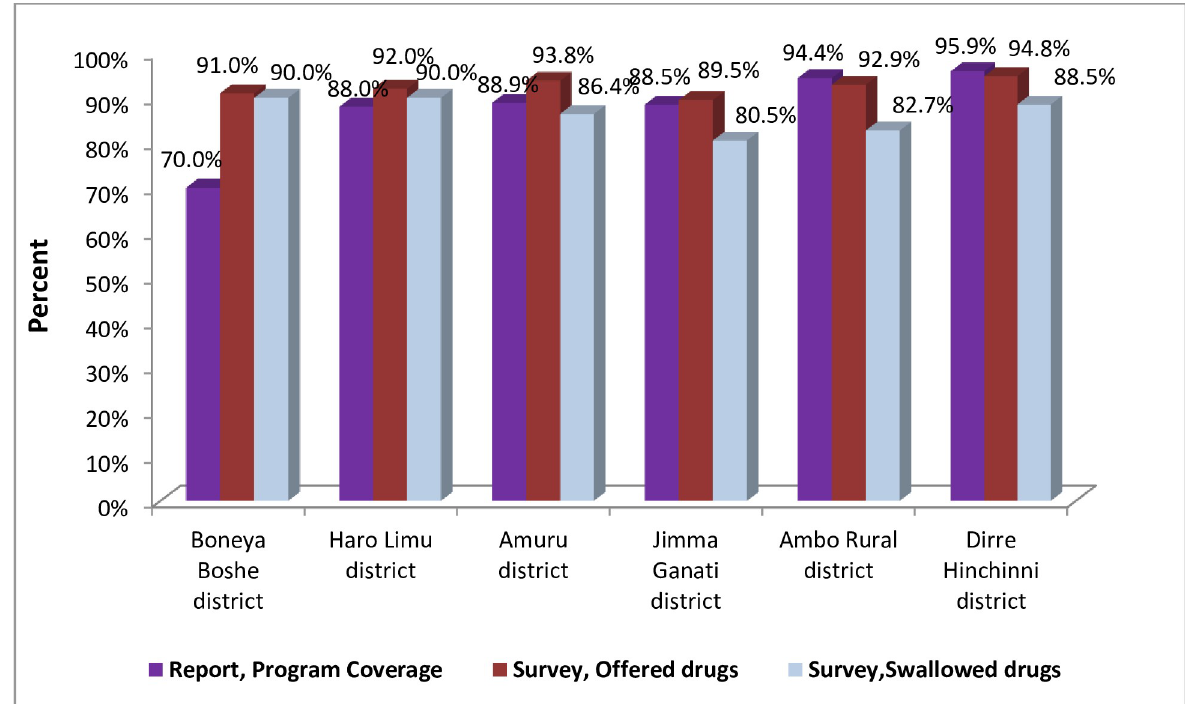
Fig 2. Comparison of MDA coverage from routine report and survey in six districts of East Wollega, Horroguduru Wollega and West Shewa zones, Oromia, 2017.